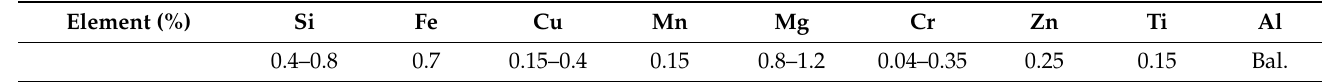
Table 1. The nominal chemical composition of the 6061 alloy extruded profiles